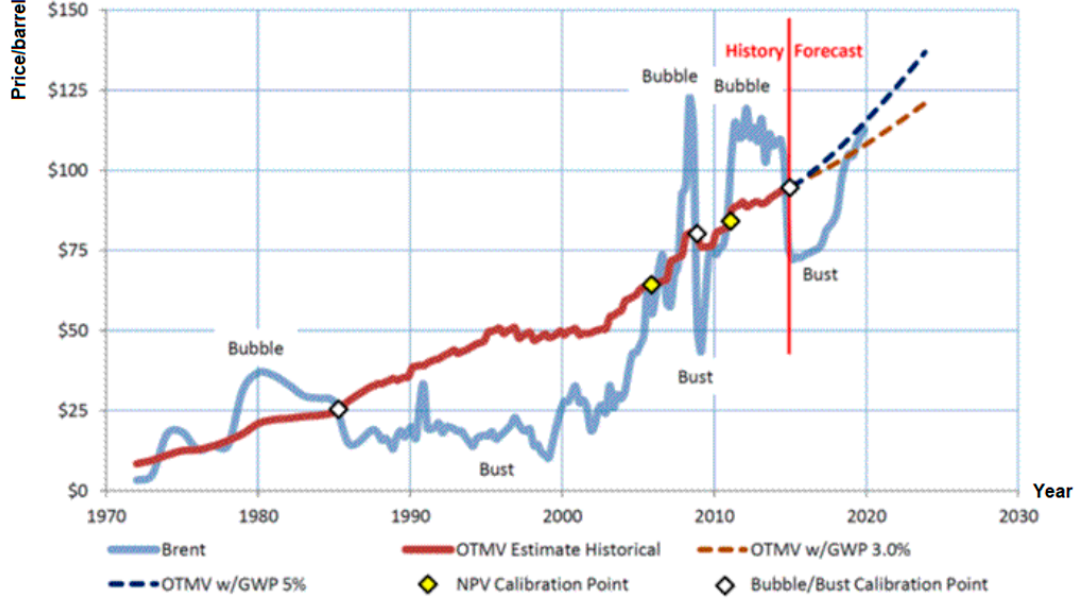
Figure 4. Brent spot price average quarterly (source: https://www.worldoil.com/news/2018/9/13/eia ‐ tighter ‐ crude ‐ oil ‐ markets ‐ contribute ‐ to ‐ higher ‐ forecast ‐ prices accessed on the 12 of November 2022).